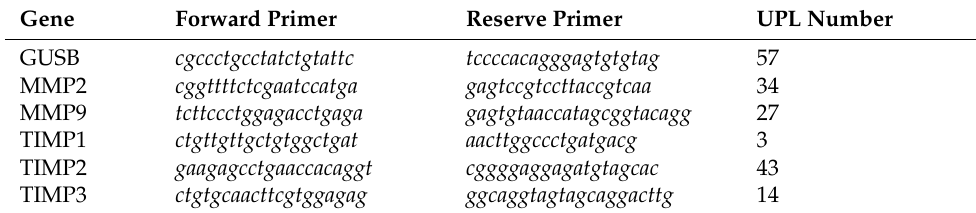
Table 2. RT-PCR primers.